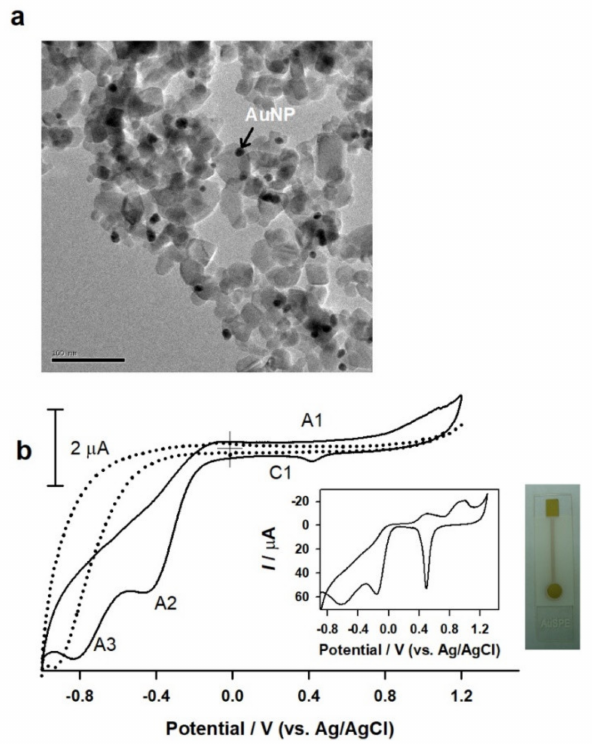
Figure 11. TEM image ( a ) and the observed cyclic voltammogram ( b ) of gold nanoparticles (AuNPs) stabilized CNP (GOQDs). Inset is a photograph of a commercial AuSPE that was used as a control in this work. Cyclic voltammograms of a bare SPCE (dotted-line) and vapor-deposition gold electrode (AuSPE, insert figure) in 0.1 M, pH 8 PBS at a scan rate of 50 mV/s are presented as